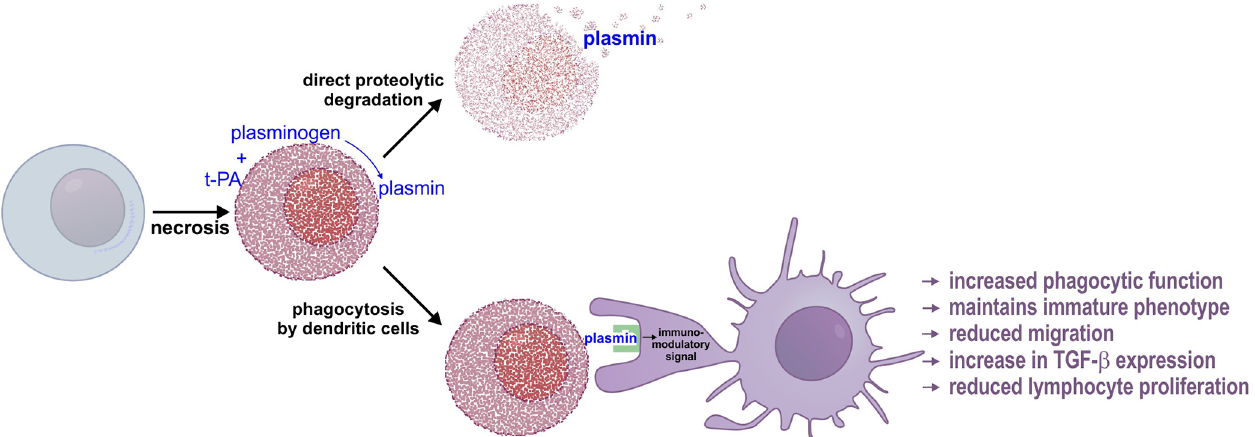
Fig 7. Working model for plasmin-mediated clearance of dead cells. Injury to a live cell results in necrosis and widespread aggregation of intracellular proteins via the phenomenon of Nucleocytoplasmic Coagulation (NCC) [7] (in red). Plasma membrane breakdown allows NCC-protein aggregates to bind t- PA and plasminogen and facilitate in situ plasmin formation [8]. Plasmin then proteolytically degrades NCC-aggregated proteins. In addition, an immature dendritic cell comes into physical contact with the necrotic cell. Plasmin directly activates dendritic cells which transduce an immunomodulatory signal to dendritic cells that instructs immunologically discrete clearance by increasing phagocytic capacity, increasing TGF- β expression, maintaining an immature phenotype, and preventing migration to draining lymph nodes. The plasmin-stimulated dendritic cell, because of its immature status and because of high TGF- β levels is unable to effectively trigger lymphocyte proliferation and adaptive